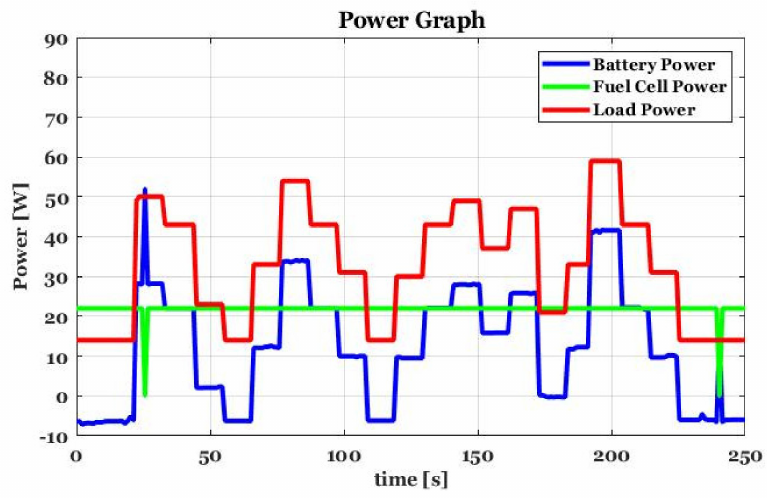
Figure 17. Experimental results based on the new sizing procedure, presenting power system